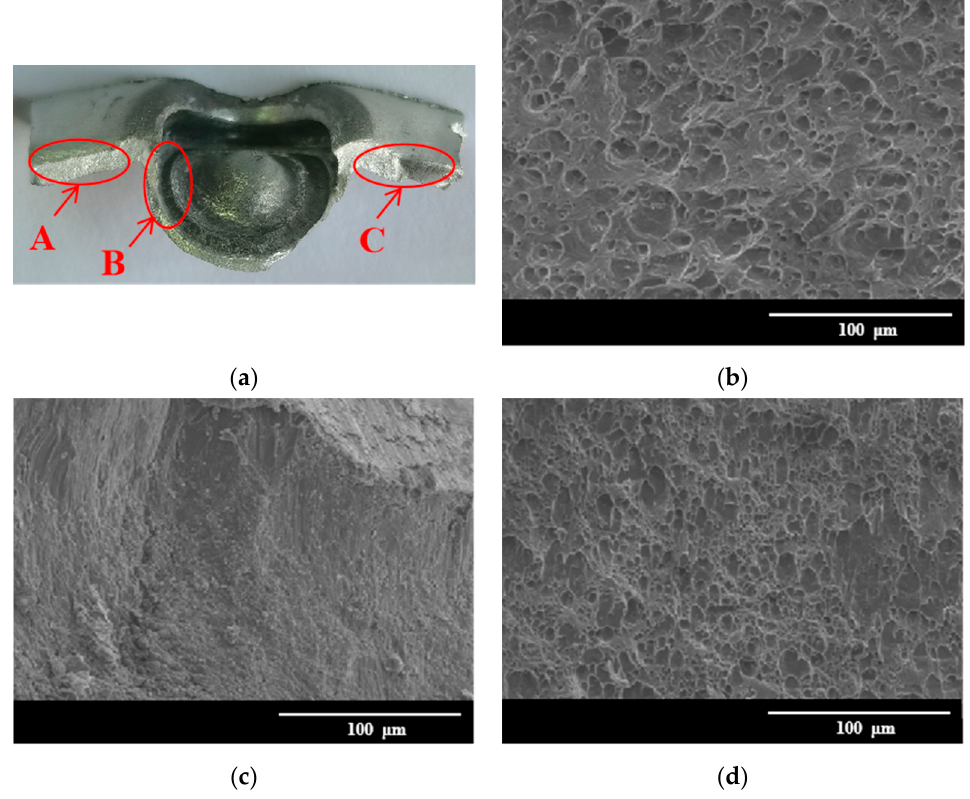
Figure 7. Tensile fracture morphologies of uncorroded joints: ( a ) macroscopic morphology of fracture; ( b ) enlarged view of area A; ( c ) enlarged view of area B; ( d ) enlarged view of area C.